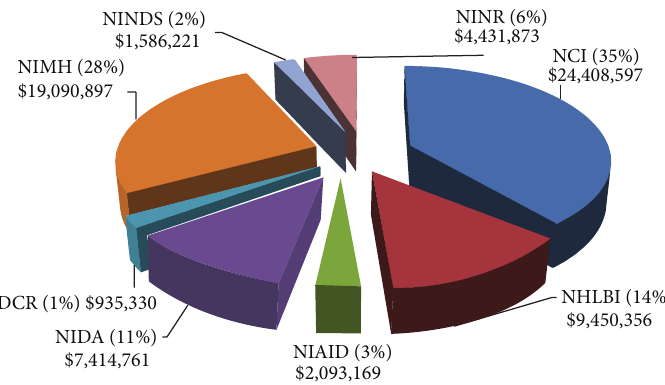
Figure 2: R01 funding by NIH Institutes, 2005–2012.